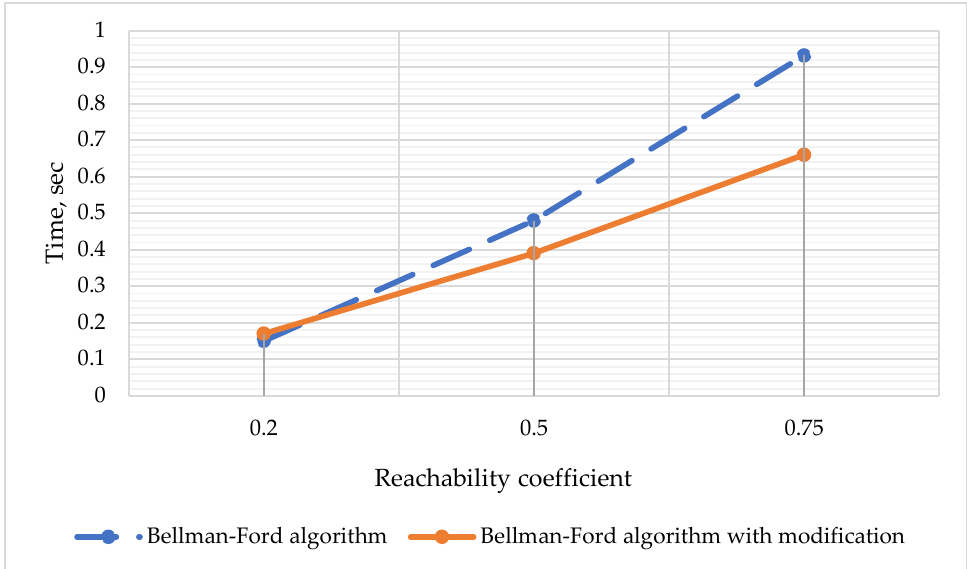
Figure 10 . Dependence of the performance of algorithms on the reachability of the MDTN with a route admissibility coefficient of 10%.